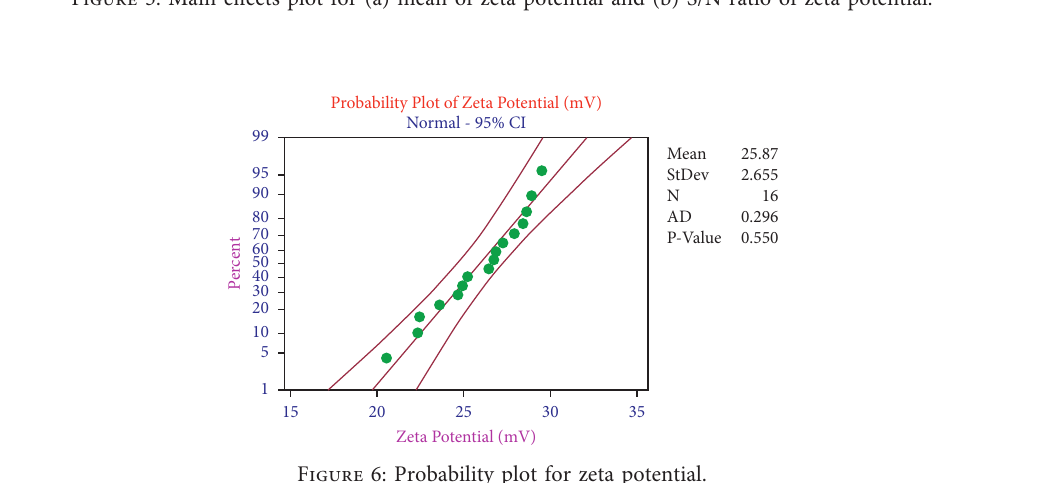
Figure 5: Main effects plot for (a) mean of zeta potential and (b) S/N ratio of zeta potential.